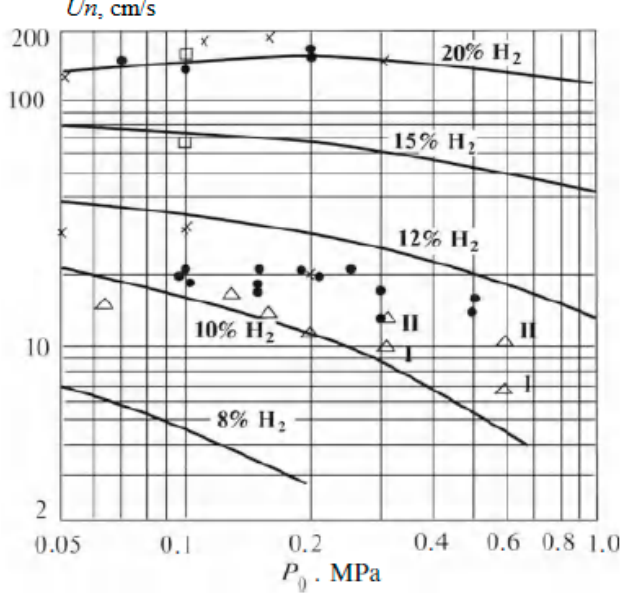
Figure 3. Dependence of flame velocity on pressure in lean hydrogen–air mixtures. Dots are data from various experiments; lines are results of calculations (Adapted with permission from ref. [19].